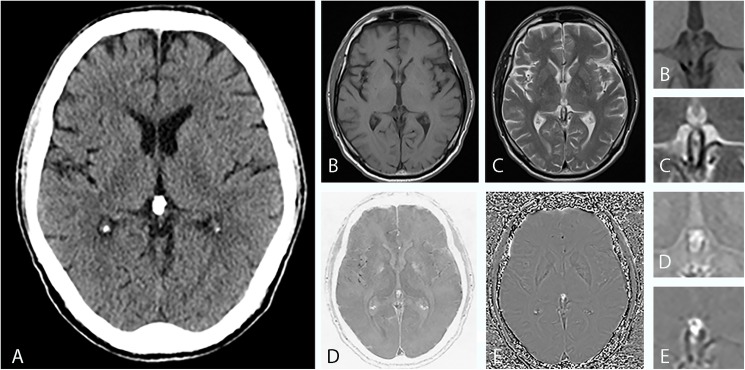
Imaging findings of a 63-year-old man with a calcified pineal gland.(A), CT shows a sharply defined oval-shaped pineal calcification with a diameter of 7 mm. In axial T1-weighted MRI (B) and in axial T2-weighted MRI (C) it is hardly possible to demarcate the calcified area against the surrounding tissue. In conventional MRI, it is not possible to reliably identify the hypointense foci as calcifications. The inverted SWMR magnitude image (D) and the phase image (E) show well-defined focal hyperintensities in the pineal region area. While the image information solely derived from the magnitude image is not superior to conventional MRI sequences, the combination of SWMR magnitude and phase image allows for a clear and reliable identification of diamagnetic calcifications. Magnified images are provided for (B), (C), (D) and (E). As CT and MRI of the brain have diverged reference lines with the bicommissural line used as a convenience standard for MRI and the orbitomeatal line used for CT, the slice angles vary slightly.